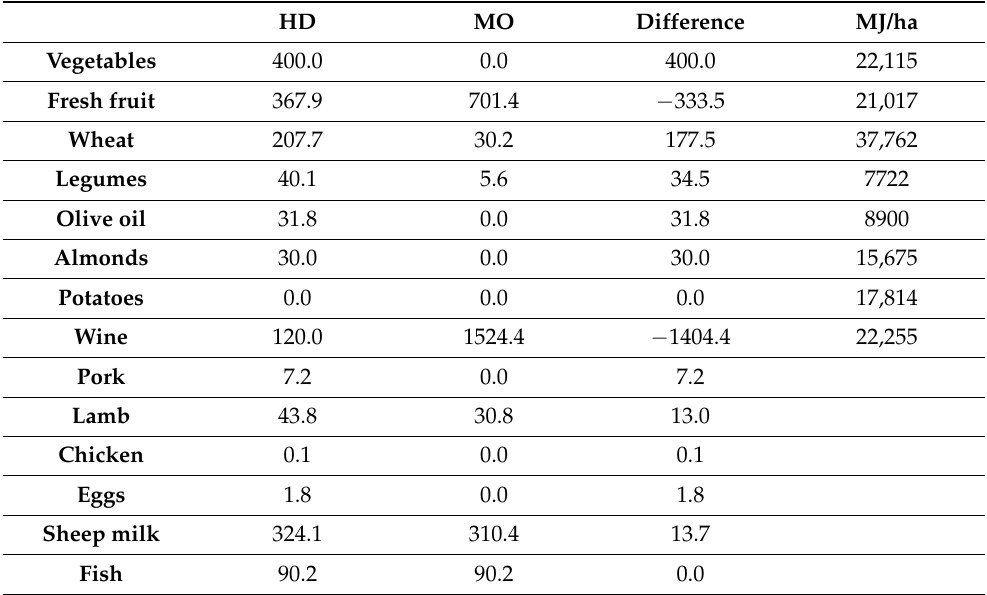
Table 1. Resulting diets for the scenarios HD and MO in grams per person and day, the difference between both scenarios, and the energy yields of human metabolizable energy per unit of cropland in each vegetable product. Source: Our own SAFRA modeling. HD MO Difference MJ/ha Vegetables 400.0 0.0 400.0 22,115 Fresh fruit 367.9 701.4 − 333.5